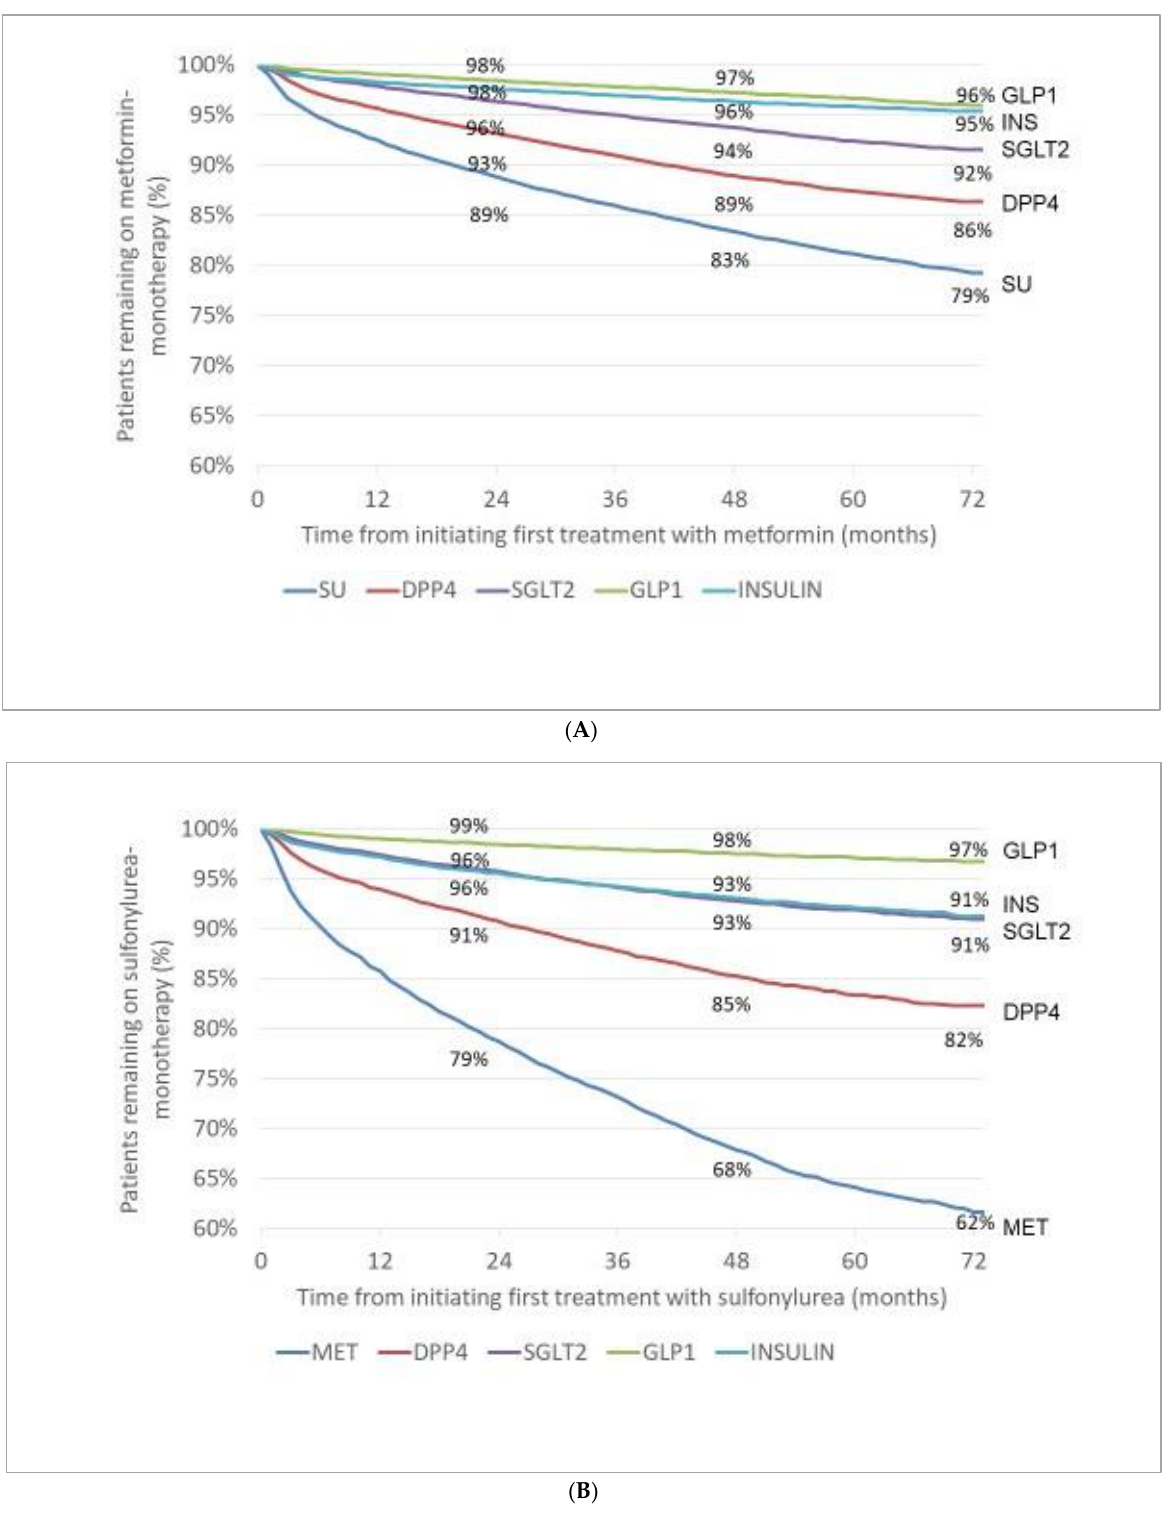
Figure 4. Incidence (appearance) of add-on treatment (either in monotherapy or in combination) after initiating first treatment with metformin (A) or sulfonylurea (B). MET: metformin, SU: sulfonylurea, DPP4: dipeptidyl peptidase-4 inhibitor, SGLT2: sodium-glucose co-transporter-2 inhibitor, GLP1: glucagon-like peptide-1 receptor agonist.